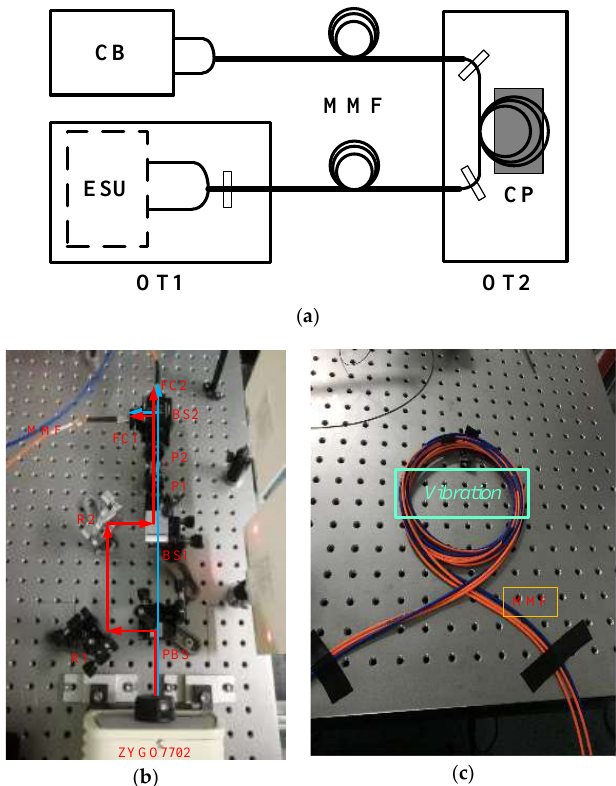
Figure 4. ( a ) The schematic diagram of the experiments. ( b ) The schematic diagram of experimental set-up on OT1. PBS is a polarizing beamsplitter, BS1 and BS2 are beamsplitters, P1 and P2 are polarizing plates, R1 and R2 are reflectors, and FC1 and FC2 are fiber couplers. ( c ) the MMFs are fixed on OT2 and disturbed by the cellphone.